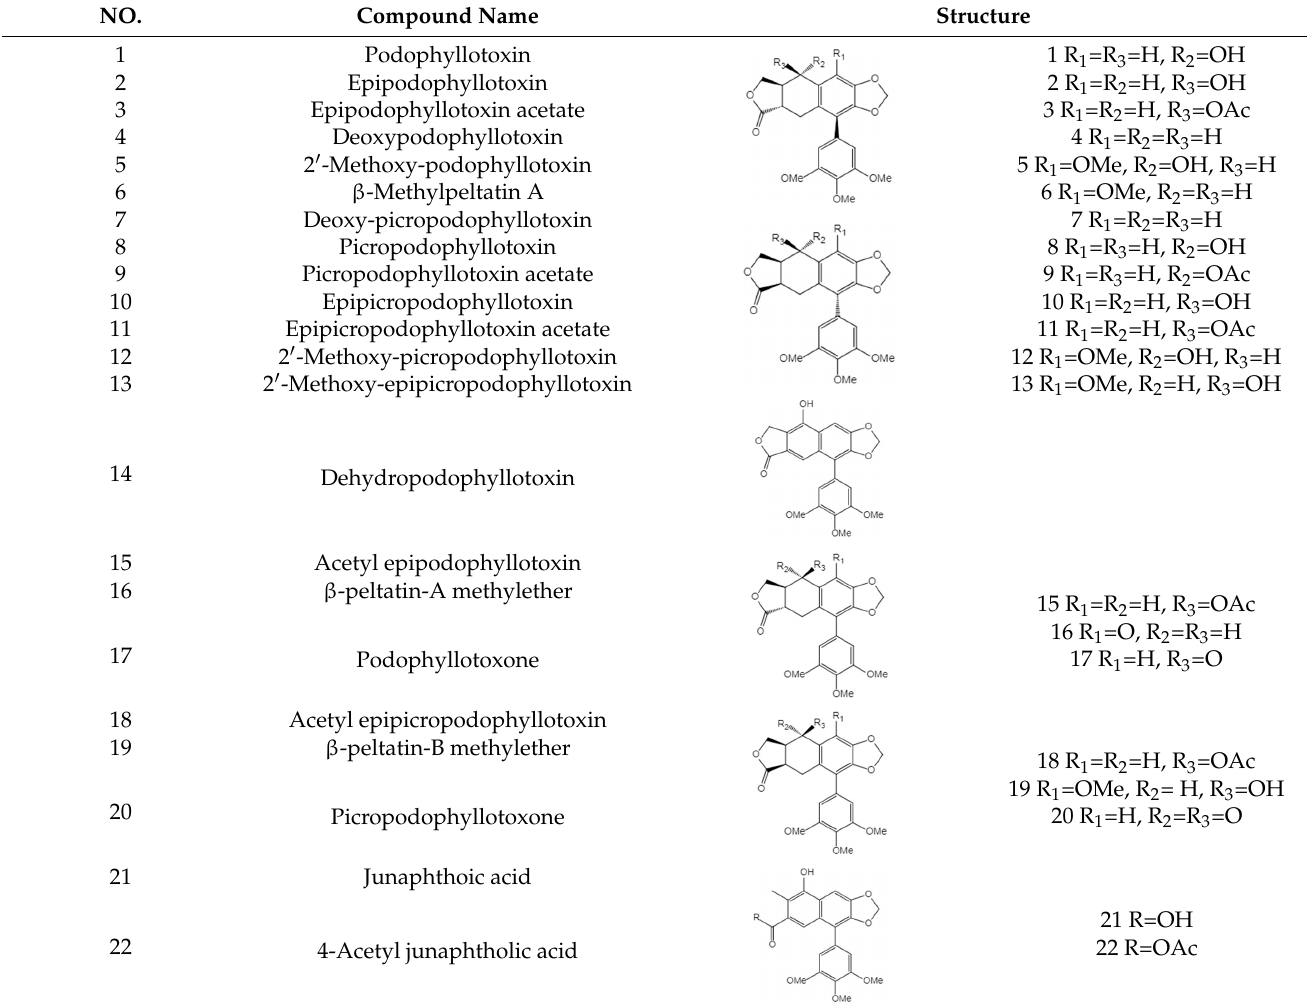
Table 1. Podophyllotoxin (1) and its analogues (2–22) isolated from J.